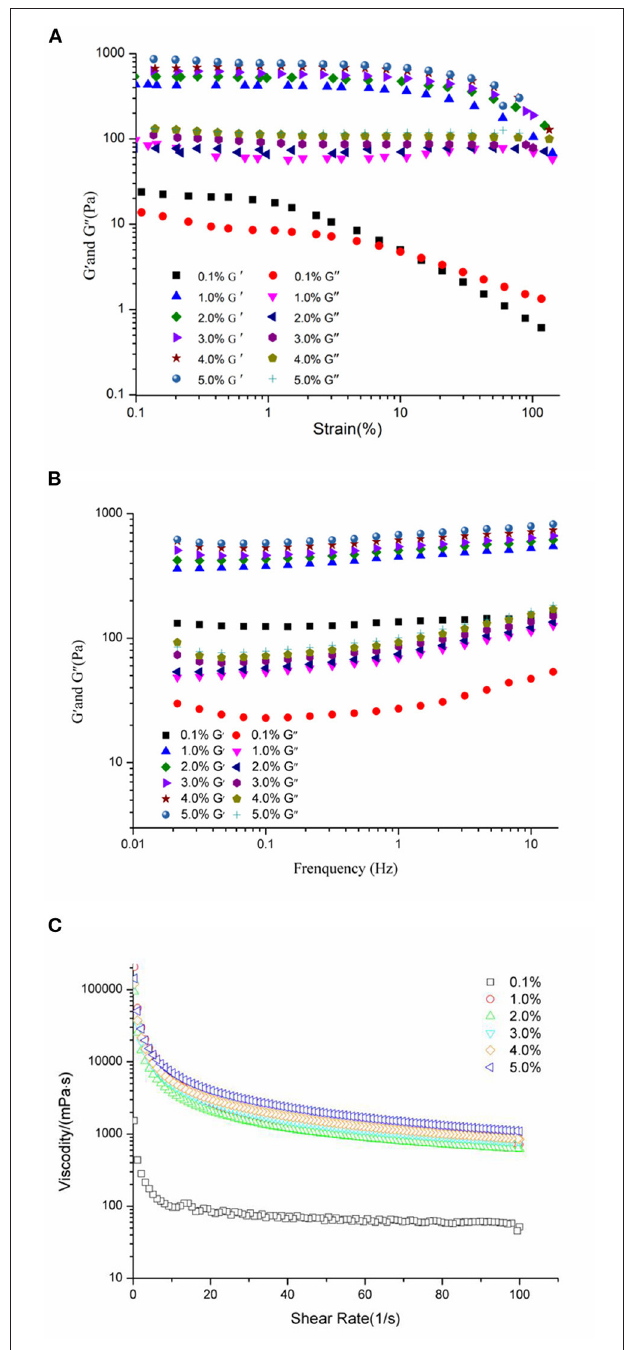
FIGURE 3 | Rheological properties of HIPEs prepared by WSP (0.1, 1, 2, 3, 4, and 5 wt%). Strain sweep (A) of the HIPEs with strain increased from 0.1 to 100% at a constant frequency of 1Hz. Frequency sweeps (B) curves at fixed strain (1%) with the frequency ranging from 0.01 to 15Hz; Apparent viscosity (C) of the HIPE samples with shear rate from 0 to 100 1/s.